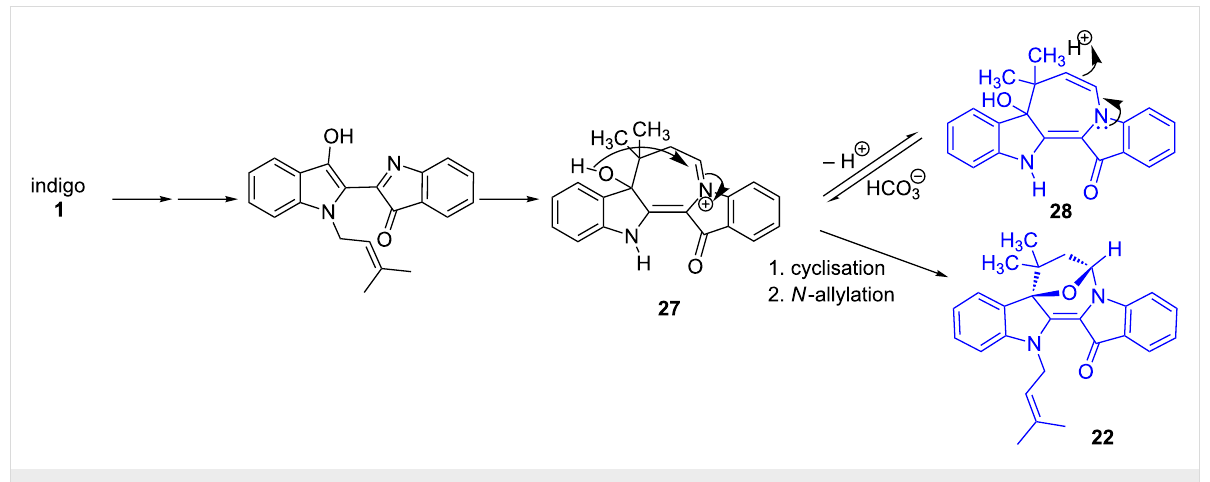
Scheme 7: Proposed mechanism for the formation of 22 . The order of protonation and allylation is undetermined.